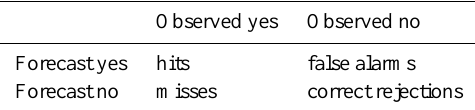
Table A1. Contingency